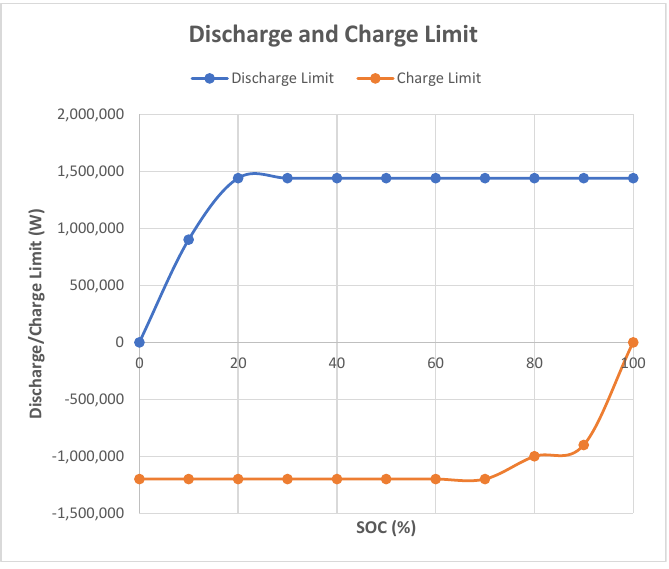
Figure 13. Discharge (positive) and charge (negative) current limits (in Watt) vs. the SOC of the battery pack.